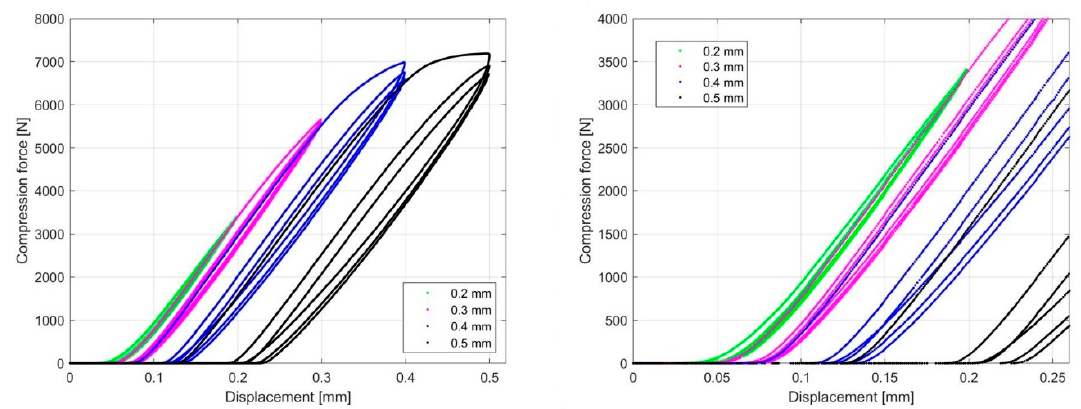
Figure 16. Compression force–displacement diagram for 1.6 mm ILD.